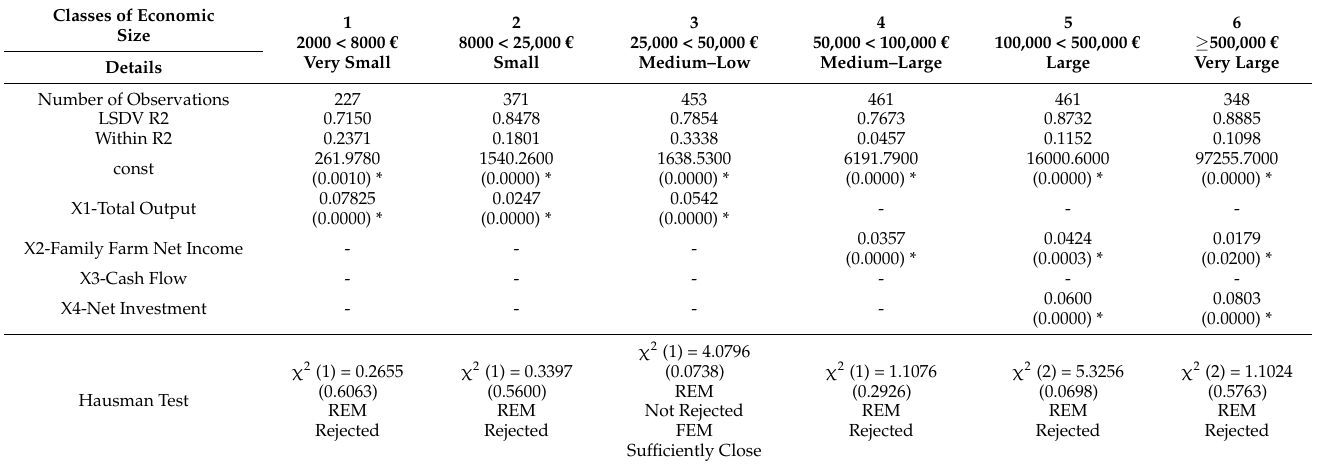
Table 4. Panel Fixed Effect Models for energy cost of the European * farms according to the economic